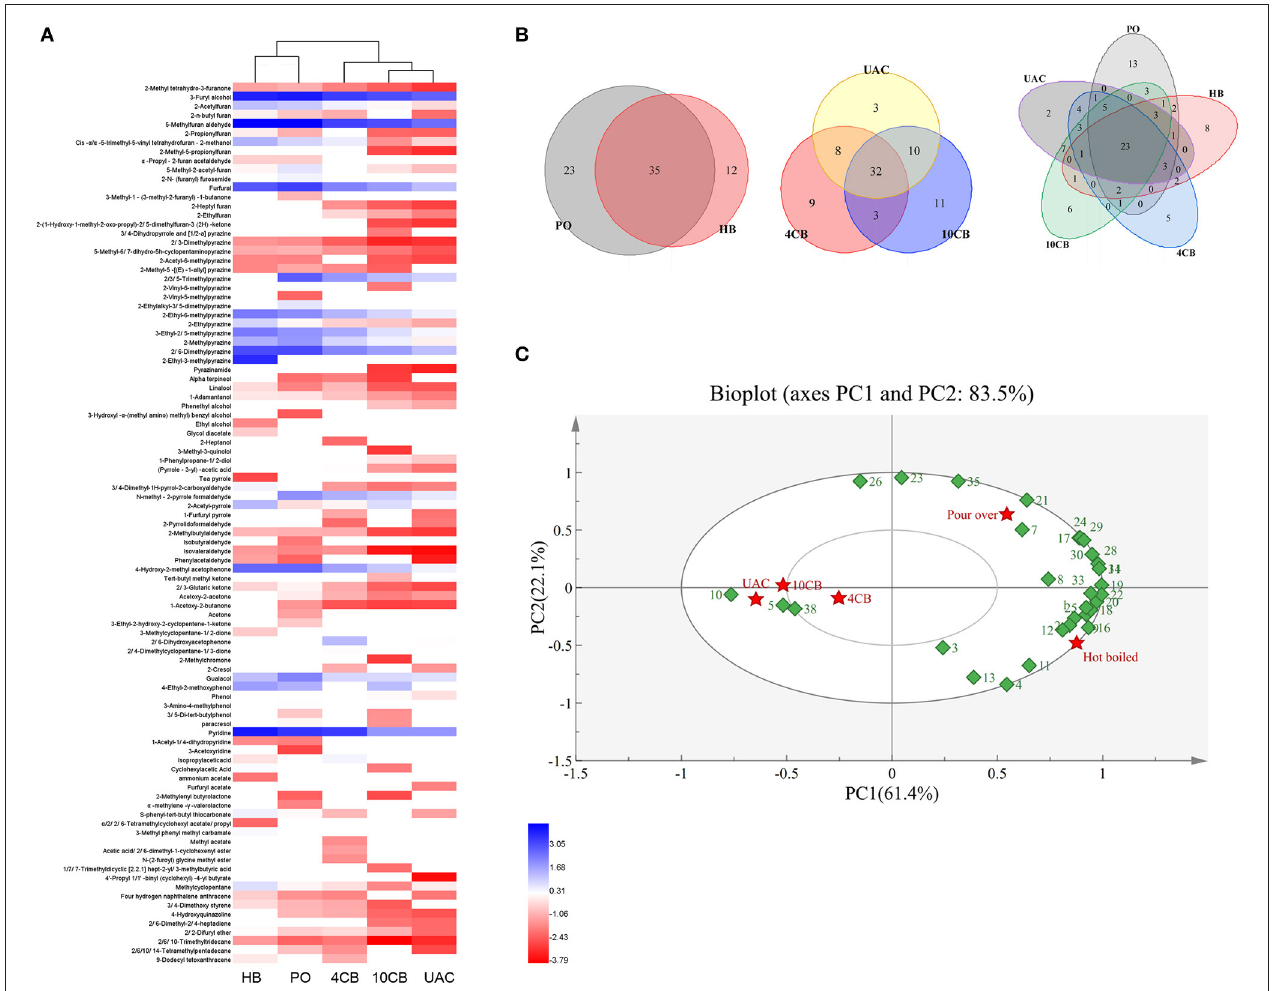
FIGURE 2 | Cluster heatmap (A) and Venn diagrams (B) of volatile compounds produced by different coffee brewing methods. (C) Principal component analysis (PCA) biplot of volatile compounds in hot and cold brew coffees. (1: 2-Propionylfuran, 2: 2, 2-Difuryl ether, 3: Isopropylacetic acid, 4: 3, 4-Dimethyl-1H-pyrrol-2-carboxyaldehyde, 5: (Pyrrole-3-yl) -acetic acid, 6: 2-N-(furanyl) furosemide, 7: 5-Methyl-2-acetyl-furan, 8: 4-Ethyl-2-methoxyphenol, 9: 2-n-butyl furan, 10: Phenol, 11: Cyclohexylacetic Acid, 12: Methylcyclopentane, 13: 2-Acetyl-pyrrole,14: 4-Hydroxy-2-methyl acetophenone, 15: 2-Ethylalkyl-3, 5-dimethylpyrazine, 16: 2-Ethylpyrazine, 17: 2, 3-Pentanedione, 18: Cis - α , α − 5-trimethyl-5-vinyl tetrahydrofuran-2-methanol, 19: 2-Acetylfuran, 20: 3-Ethyl-2, 5-methylpyrazine, 21: Guaiacol, 22: 2-Ethyl-6-methylpyrazine, 23: 2,3,5-Trimethylpyrazine, 24: 2-Methylpyrazine, 25: Pyridine, 26: N-methyl-2-pyrrole formaldehyde, 27: Furfuryl acetate, 28: 2, 6-Dimethylpyrazine, 29: Furfural, 30: 3-Furyl alcohol, 31: 5-Methylfuran aldehyde, 32: 3-Methyl phenyl methyl carbamate, 33: S-phenyl-tert-butyl thiocarbonate, 34: 2-Ethyl-3-methylpyrazine, 35: Paracresol, 36: 3-Amino-4-methylphenol, 37: 2, 4-Dimethylcyclopentane-1, 3-dione, 38: 2,6-Dihydroxyacetophenone). HB, Hot boiled, PO, Pour-over, 4 CB, 4 ◦ C cold brew, 10 CB,10 ◦ C cold brew, UAC, Ultrasound-assisted cold